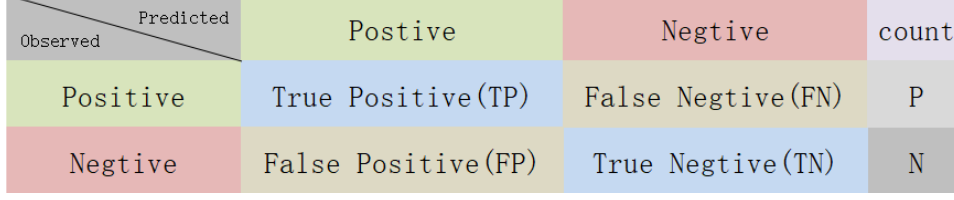
Figure 7. Confusion matrix.